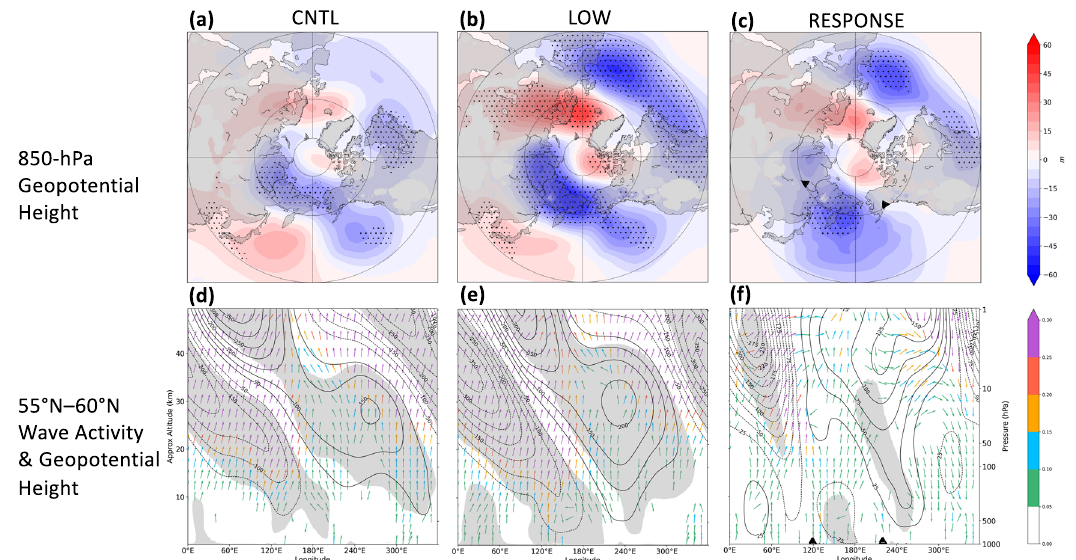
Fig. 6 Composite geopotential height and wave activity fl ux. 850-hPa longitude-latitude cross-section of geopotential height anomaly in CNTL ( a ), LOW ( b ), and response ( c ), 55°N – 60°N longitude ‐ height cross-section of the eddy component of geopotential height anomalies (contours; in m) and wave activity fl ux anomaly (vector; in m 2 s − 2 ) in CNTL ( d ), LOW ( e ), and response ( f ) averaged from day -10 to day -1 prior the onset. Stippling and shading indicate statistical signi fi cance at the 95% level. The black triangles mark the longitudinal edges of the sea ice loss